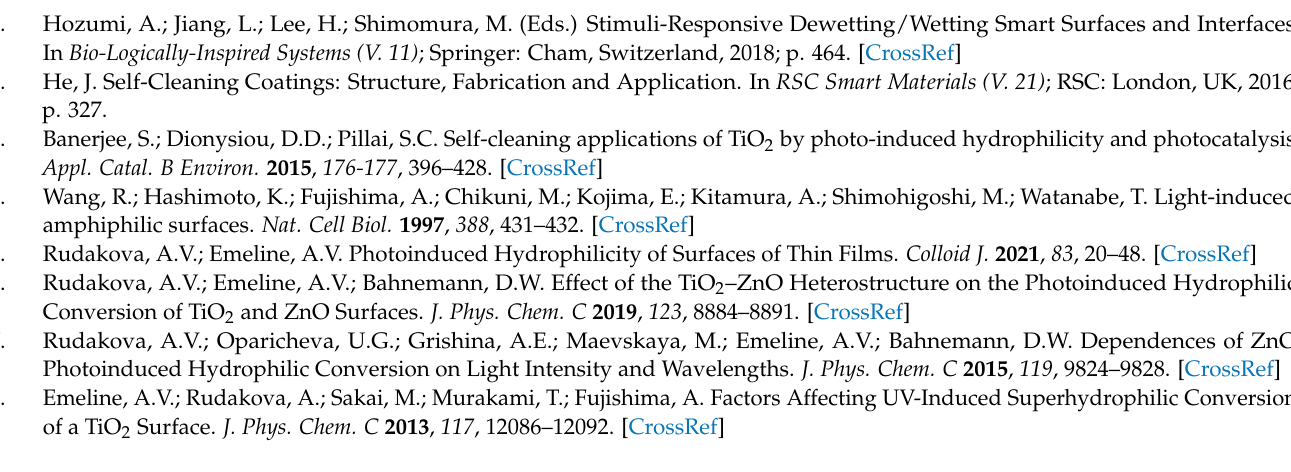
tured coatings, Figure S2: XRD patterns of Cu 2 O, ZnO and ZnO/Cu 2 O heterostructured coatings, Figure S3: SEM images of the TiO 2 surface and TiO 2 /Cu 2 O cross-section of the TiO 2 /Cu 2 O coating, Figure S4: SEM images of the TiO 2 surface and TiO 2 /Cu 2 O cross-section of the TiO 2 /Cu 2 O coating, Figure S5: AFM image of the TiO 2 surface and roughness profile of the TiO 2 /Cu 2 O coating, Figure S6: AFM image of the ZnO surface and roughness profile of the ZnO/Cu 2 O coating, Figure S7: Transmit- tance spectra of: (a) TiO 2 /Cu 2 O heterostructured coating and its components; and (b) ZnO/Cu 2 O heterostructured coating and its components, Figure S8: Tauc plots for 1 – Cu 2 O, 2 – ZnO, and 3 – TiO 2 ., Figure S9: Alteration of the total SFE caused by irradiation with visible and UV light, Figure S10: Alteration of the SFE polar component caused by irradiation with visible and UV light, Figure S11: Alteration of the SFE dispersive component caused by irradiation with visible and UV light, Figure S12: Alteration of the work function of nanocoatings induced by wetting and UV and visible light